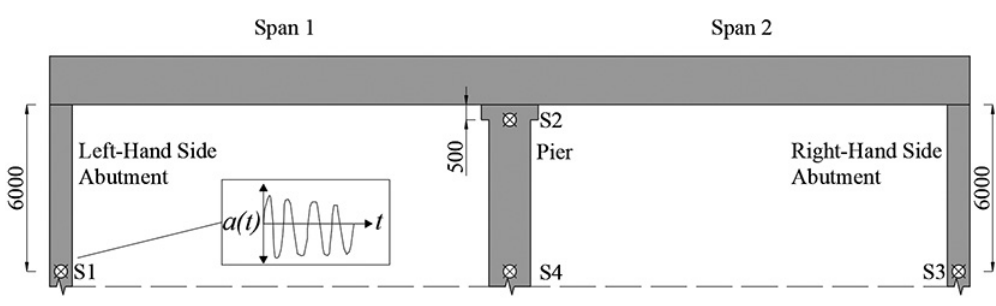
Figure 2. Sensor locations to locate the scour holes on the two-span integral bridge (Prendergast, Gavin, & Hester,